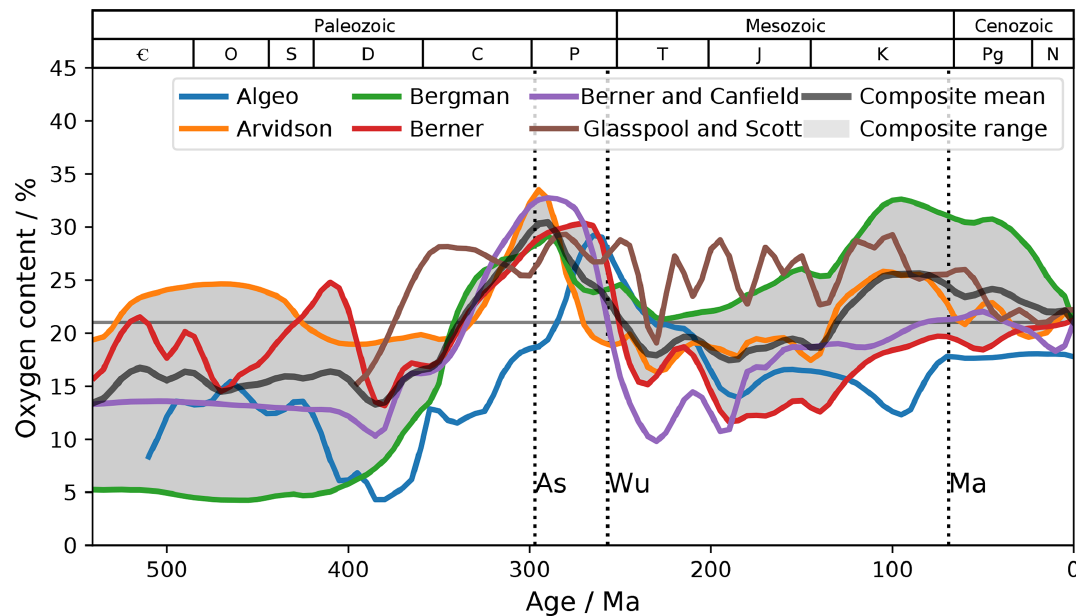
Figure 1. Oxygen content reconstructions in the Phanerozoic from Algeo and Ingall (2007), Arvidson et al. (2013), Bergman et al. (2004), Berner (2009), Berner and Canfield (1989) and Glasspool and Scott (2010). The mean (black line) and range (grey shading) of the Arvidson et al. (2013), Bergman et al. (2004) and Berner (2009) is indicated, as these reconstructions were most consistent with ice core evidence (Stolper et al., 2016). Present-day atmospheric oxygen content is indicated by the solid horizontal grey line. Timings of the palaeo case studies explored in this study are indicated by the dotted vertical lines (As: Asselian, Wu: Wuchiapingian, Ma: